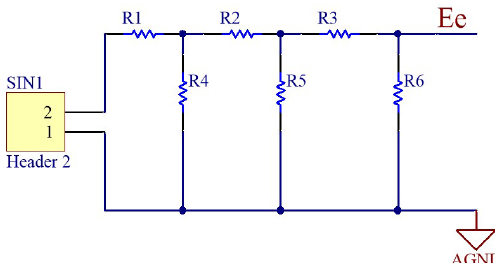
Figure 11. Resistive attenuation network.